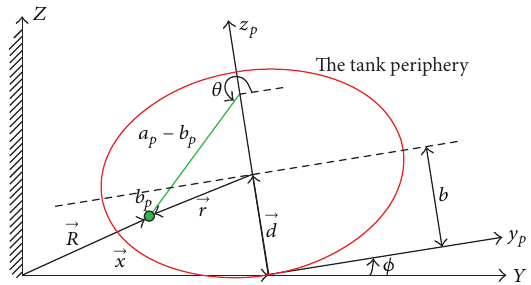
Figure 3: Analytical diagram for the motion of the trammel pendu- lum under the noninertial coordinate